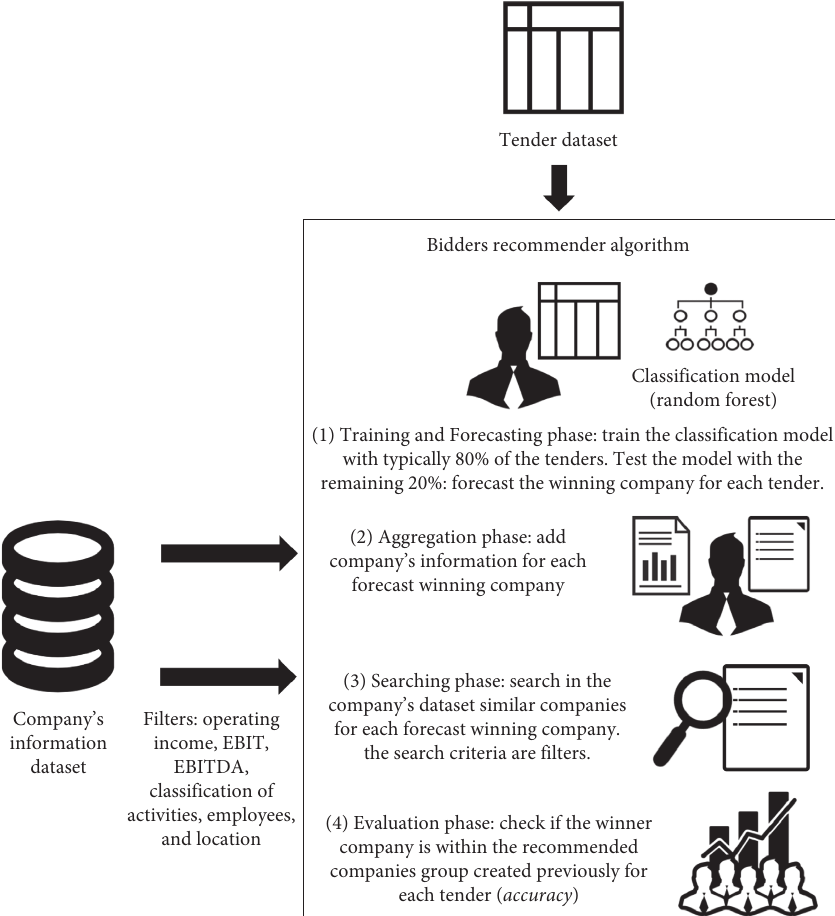
Figure 2: Flowchart of the creation of the bidders